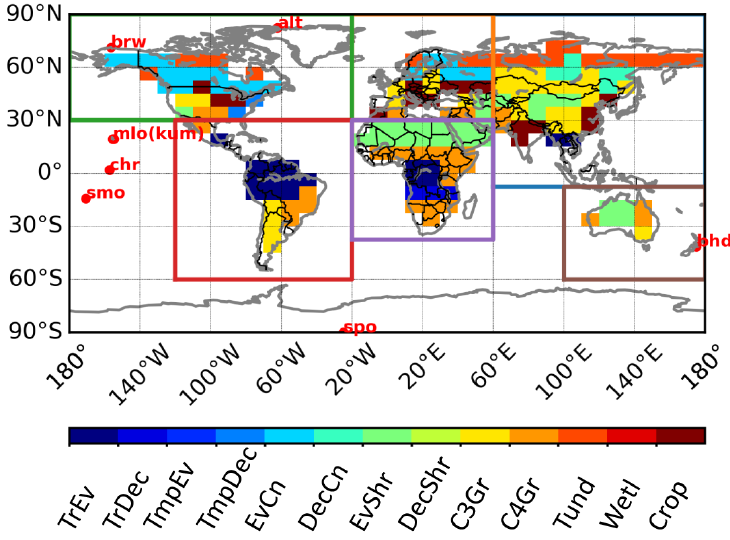
Figure A7. Global vegetation map and continental boundaries as well as atmospheric CO 2